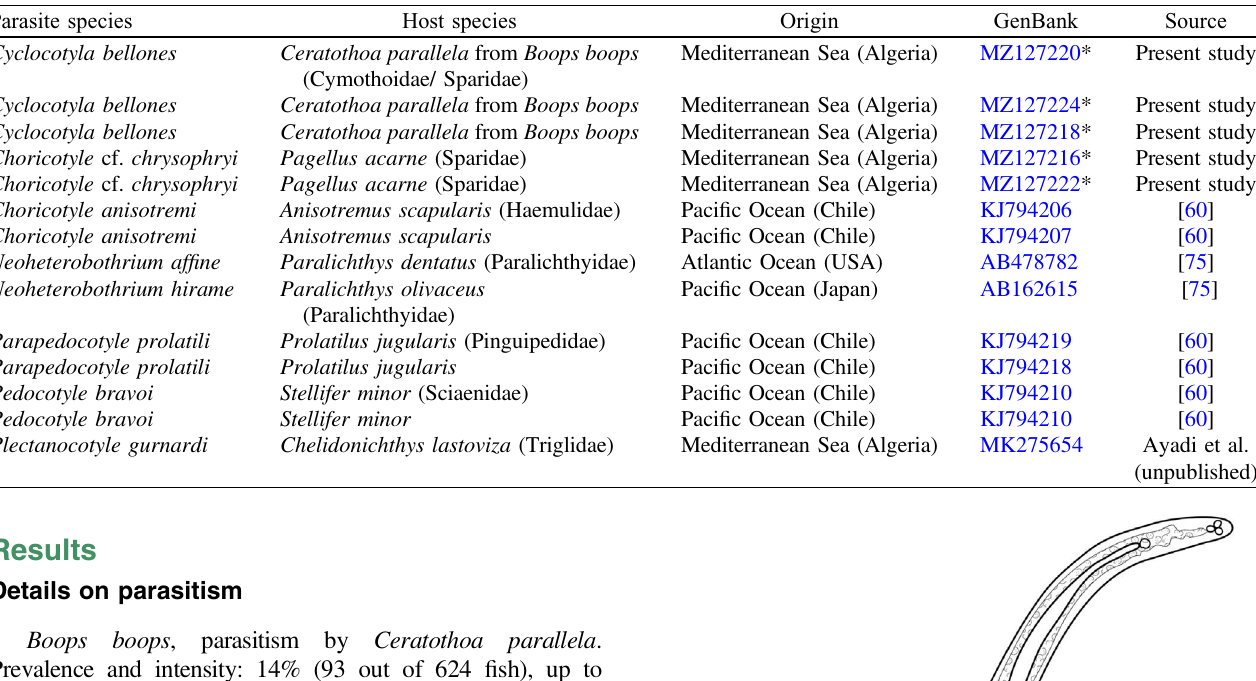
Table 5. Accession numbers of COI sequences used in the molecular analysis of diclidophorid monogeneans. *, new sequences.